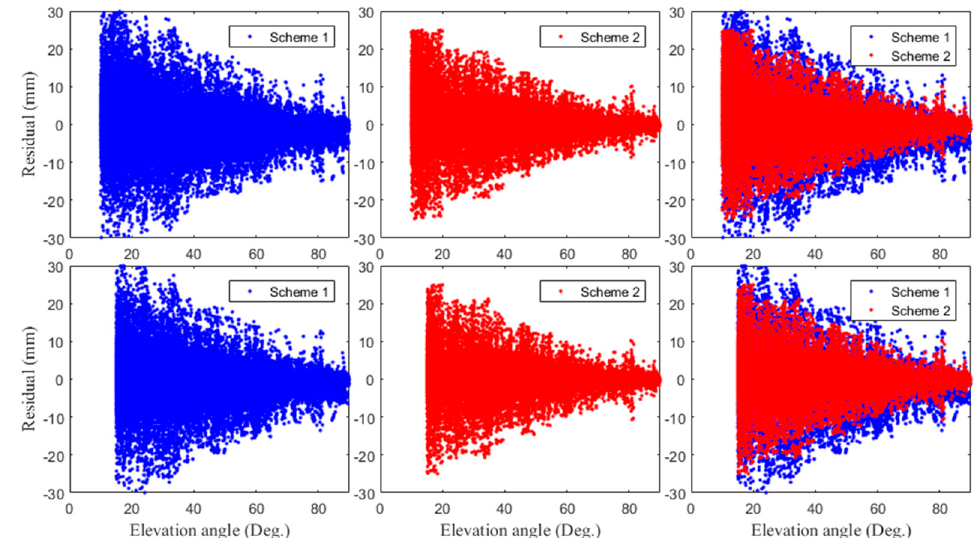
Figure 5. Scatter diagram of the slant wet delay residual using two schemes with 10° (top) and 15° (bottom) elevation angle mask over the experimental period of Doy 303 to 317, 2015.